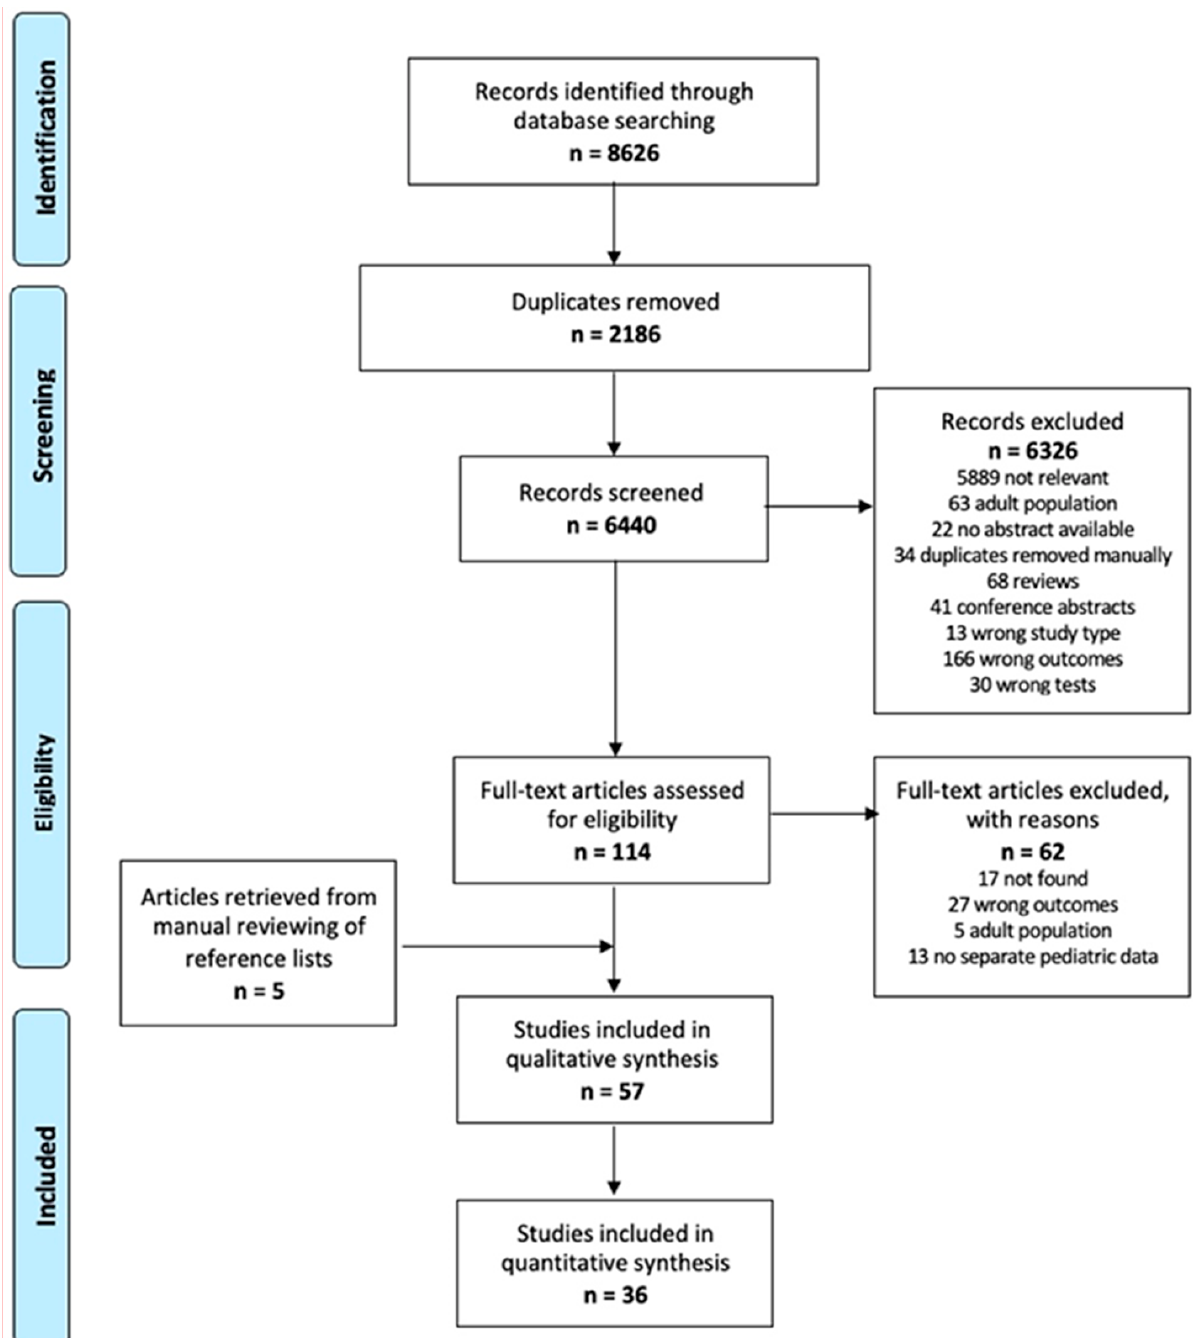
Figure 1. Flowchart of the study selection process (PRISMA). The most frequent rapid tests or POCTs implemented were the Rapid Influenza Di- agnostic Test (RIDT) (22/57, 38.6%) and Film Array–Respiratory Panel (FA-RP) (22/57, 38.5%), followed by Strep A rapid tests (7/57, 12.3%) and others testing Respiratory Syncy- tial Virus (RSV) or the combination of RSV and influenza. Only one study focused on the implementation of a rapid PCR test for Mycoplasma pneumoniae